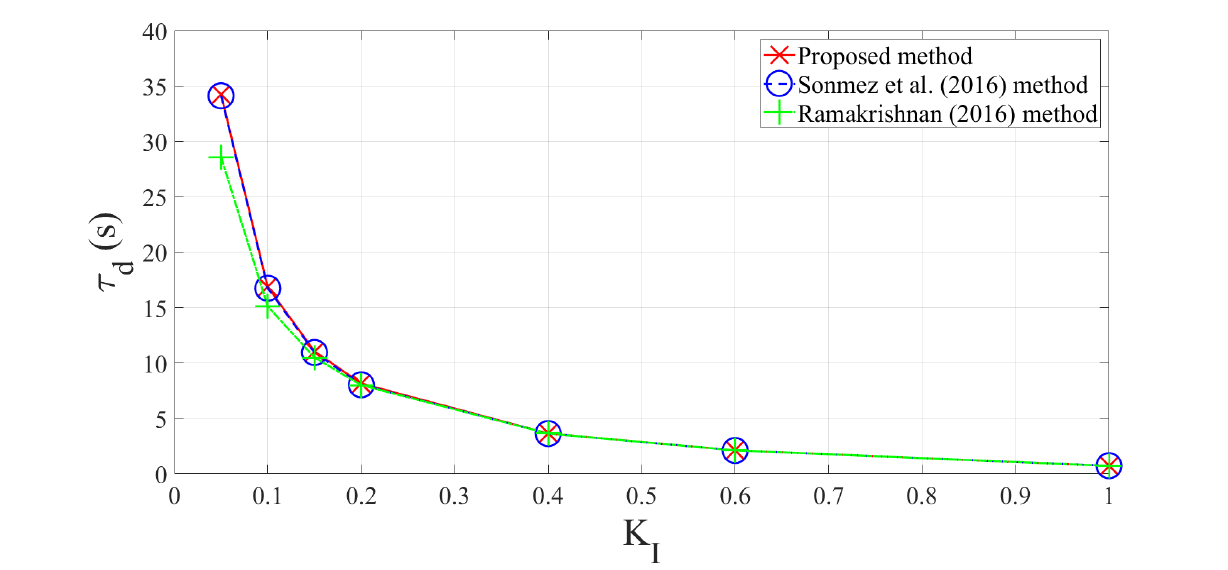
Figure 5. With K P = 0.1, the DM, τ d , is shown against the integral gain, K I , curve [18,28].